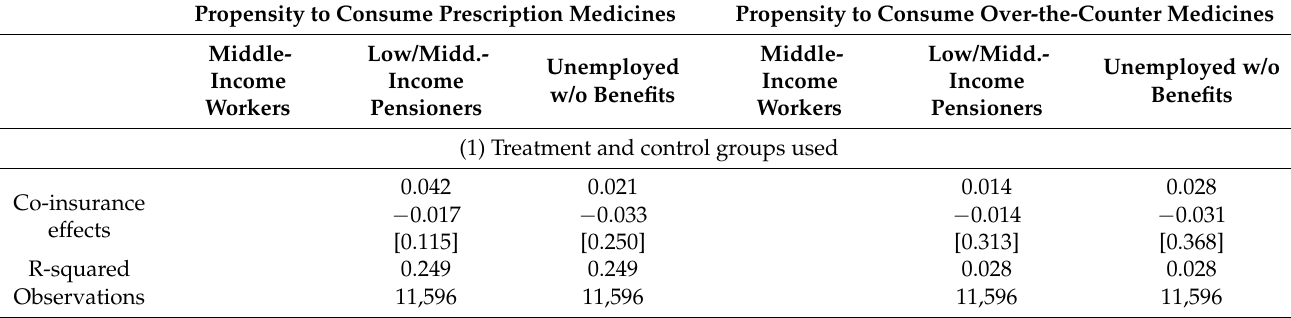
Table 9. Results for the sensitivity